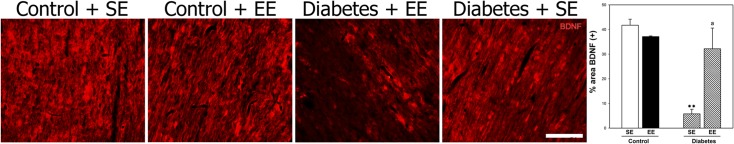
BDNF immunoreactivity in the distal ON after 6 weeks of diabetes.In diabetic animals housed in SE, a significant decrease in BDNF immunostaining was observed in the distal portion of the ON, whereas in the ON from diabetic animals housed in EE, BDNF immunoreactivity was similar to that found in non-diabetic animals kept in SE or EE. Shown are photographs representative of 5 ONs from different animals per group. Scale bar = 50 μm.